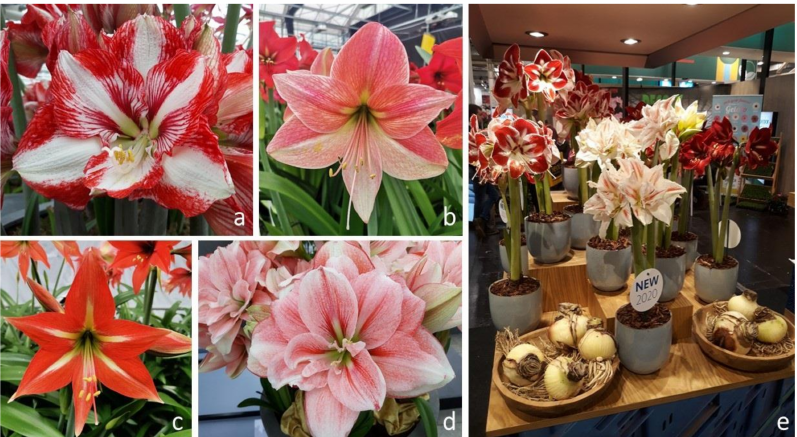
Figure 2. Novelties of Hippeastrum cultivars. ( a ) Cultivar ‘Pierrot’ from the Galaxy Group presented by Dutch Breeding Company Fa. Gebr van Velden at Keukenhof Exhibition, the Netherlands, 2018; ( b ) breeding clone 0004-5 as result of further crossing of Hippeastrum × chmielii at Warsaw University of Life Sciences, Poland, preliminary classified as the Galaxy type; ( c ) breeding clone 0021-9 as result of further crossing of Hippeastrum × chmielii at Warsaw University of Life Sciences, Poland, preliminary classified as the Diamond type; ( d ) cultivar ‘Pink Glory’ belongs to the Double Galaxy Group, presented by Dutch Breeding Company Floralia at the Keukenhof Exhibition 2018; ( e )